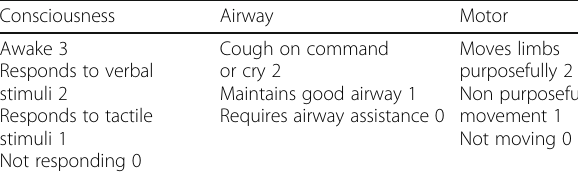
Table 2 Modified steward recovery scoring system (Steward 1975)